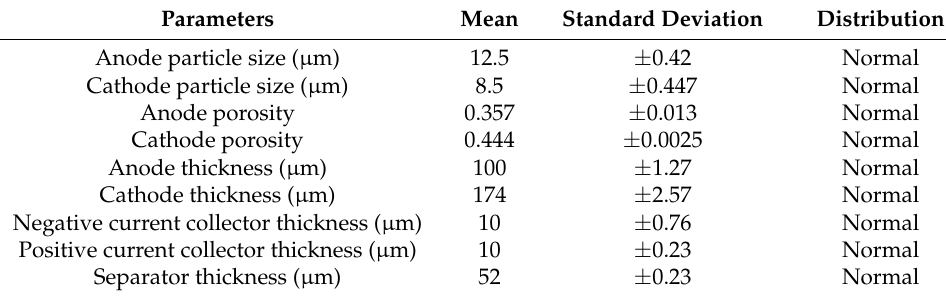
Table 2. Probabilistic distributions of LIB cell parameters